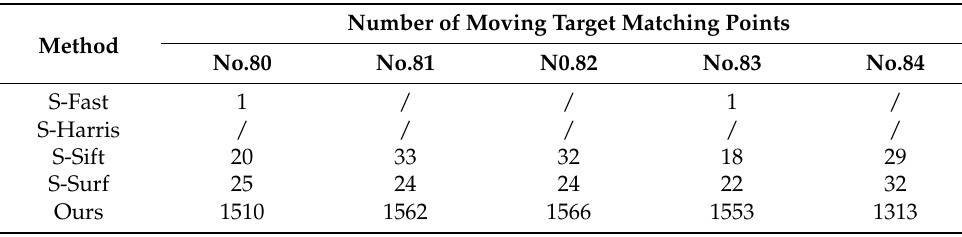
Table 2. The number of detected matching point pairs in the moving target area.